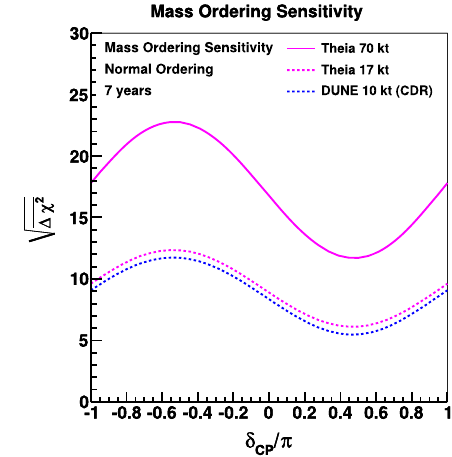
Fig. 6 Expected event rates in antineutrino mode as a function of reconstructed neutrino energy for Theia -100 after 3.5 years in the LBNF beam for the three selected antineutrino-mode samples: one ring (top left), two ring (top right), three ring (bottom) with zero Michel